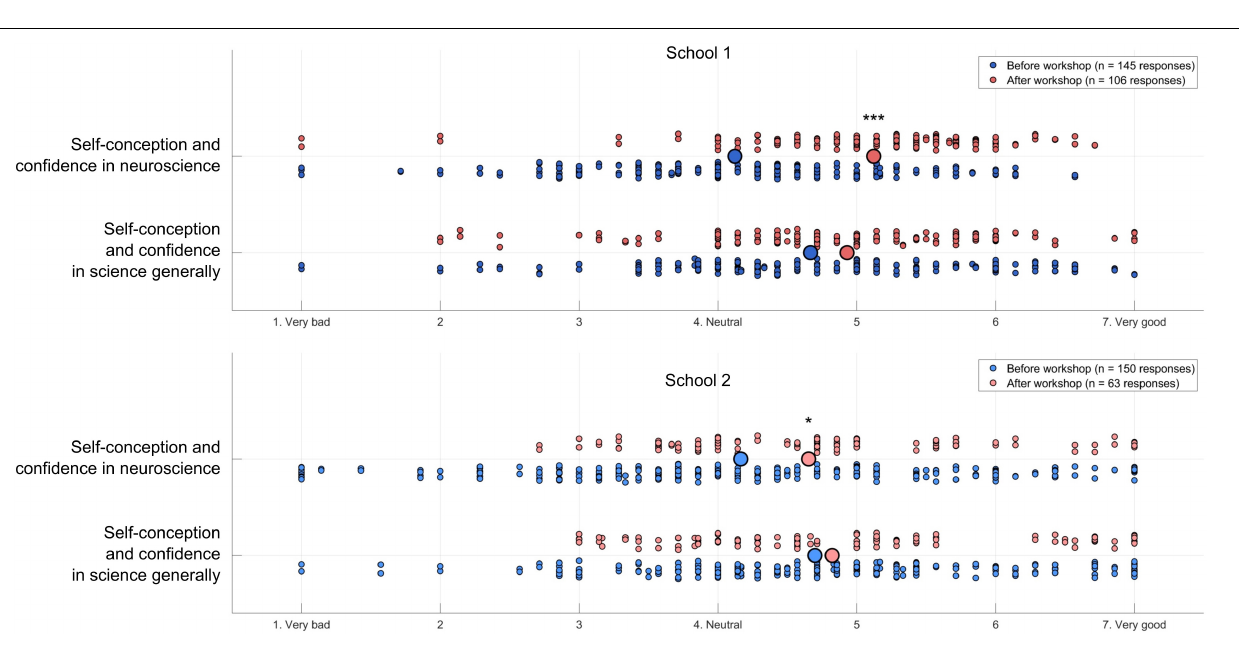
FIGURE 4 | Neuroscience content quiz results. Students’ results on a neuroscience quiz ( n = 295 pre-workshop responses, 169 post-workshop responses). Large circles indicate average responses. Wilcoxon rank sum: * p < 0.05, *** p < 0.000000000005.